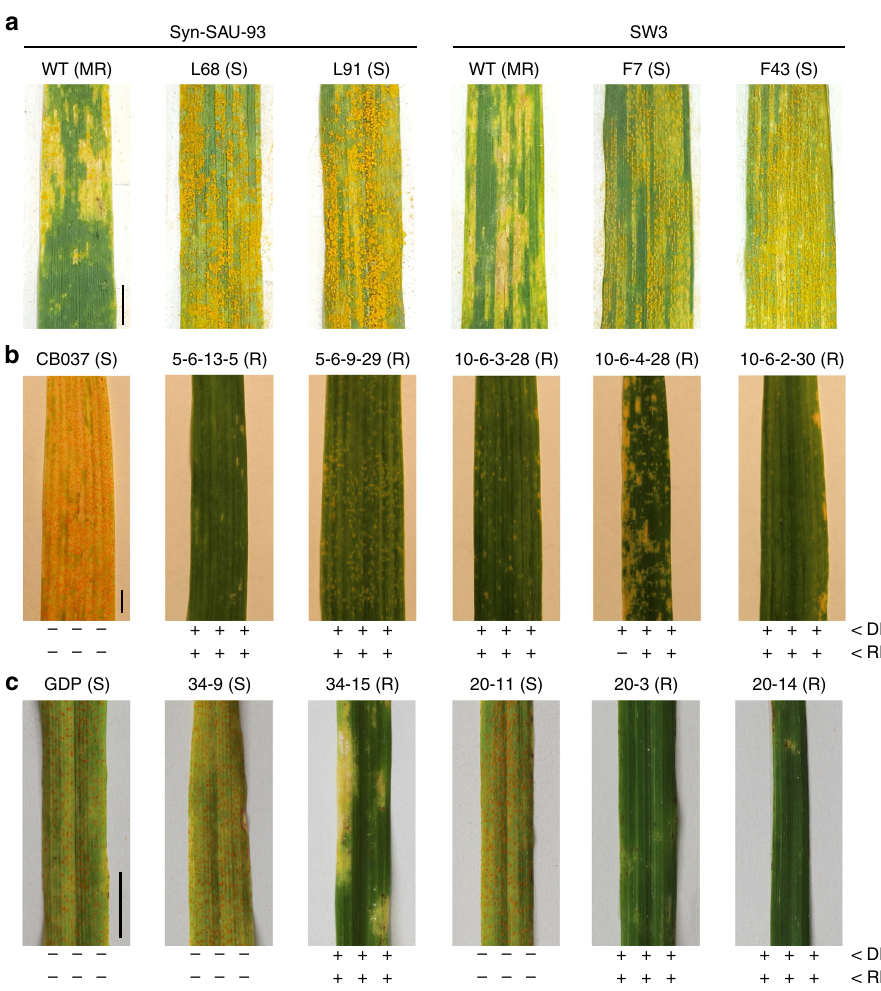
Fig. 2 The YrAS2388 locus confers stripe rust resistance in wheat and barley. a Syn-SAU-93 and SW3 are two synthetic hexaploid wheat (SHW) lines that express the YrAS2388R gene. WT is the resistant wild-type control with necrotic lesions. L68 (G117D), L91 (V267I), F7 (S394N) and F43 (V482I) are susceptible mutants with sporulating Pst . Plant responses (MR = moderate resistance; R = resistant; S = susceptible) to Pst are indicated in parentheses. b The susceptible hexaploid wheat CB037 was transformed with the intact PC1104 ( = F2-1). Transgenic T 3 wheat (all from the No. 5 and 10 T 2 subfamilies) was challenged with PSTv-239 at the adult plant stage. Under each picture, PCR results as positive (plus signs) or negative (minus signs) for DNA ampli fi cation (upper) and RNA expression (lower) of the three target genes: RLK 4DS-1 (left), RLK 4DS-2 (middle) and NLR 4DS-1 (right). RT-PCR is illustrated in Supplementary Fig. 4. c The susceptible barley Golden Promise (GDP) was transformed with the intact PC1104 ( = F2-1). Transgenic T 1 barley seedlings were inoculated with race PSH-72 of Puccinia striiformis f. sp. hordei ( Psh ). Scale bar = 1 cm. Source data are provided as a Source Data